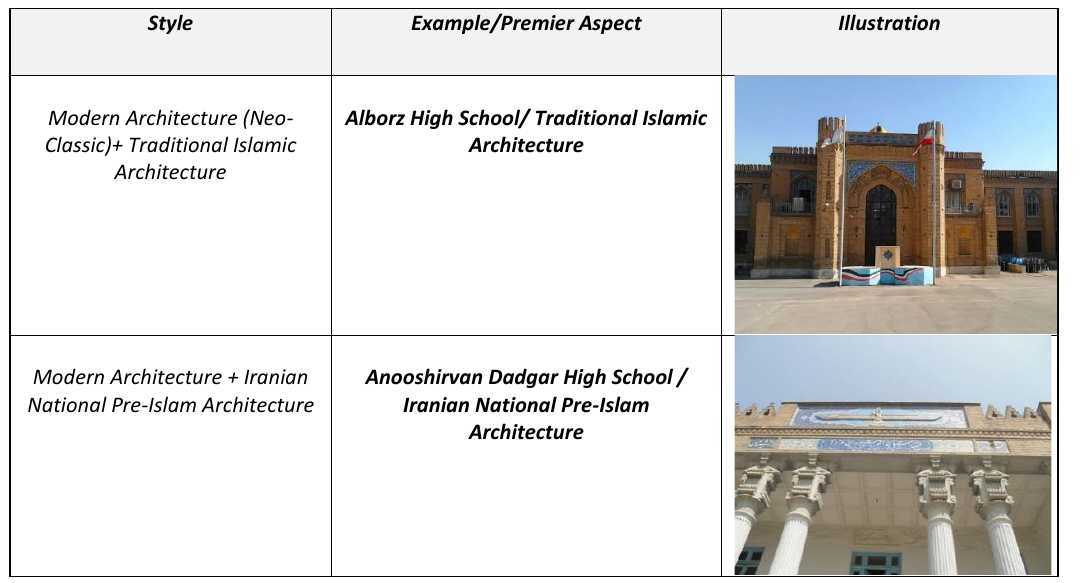
Markov, The modern architecture and Iranian ancient